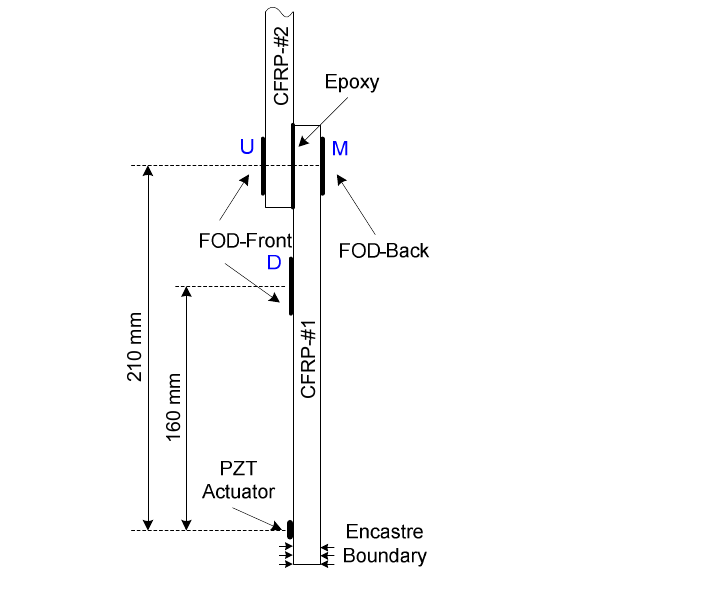
Figure 7. Transducer network setup in the